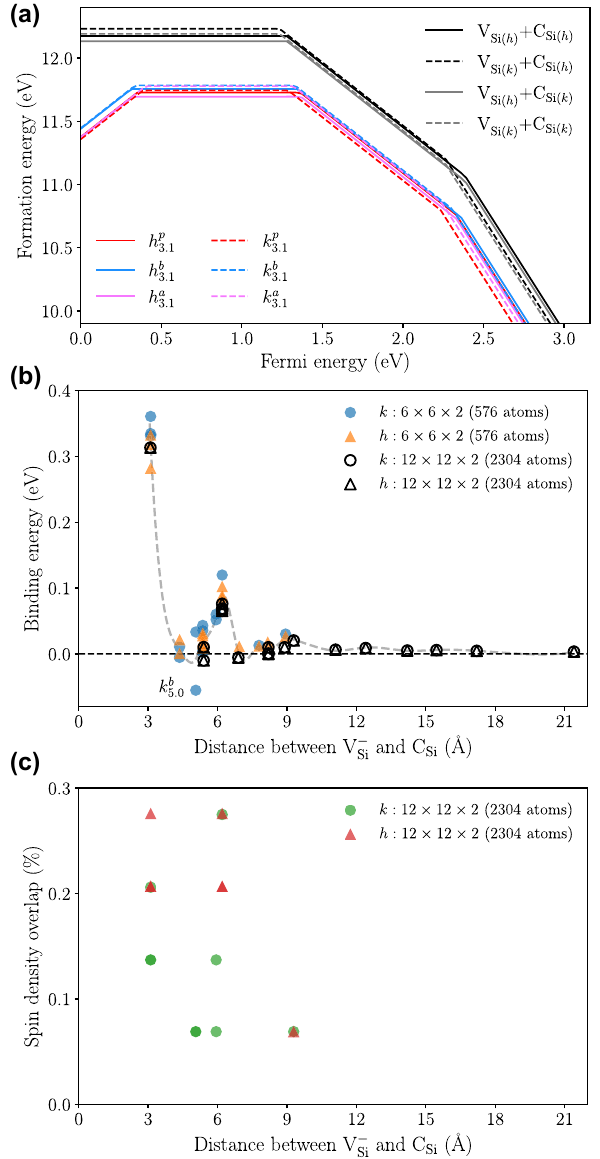
Figure 2: Energetics and the site dependent behavior of modified silicon vacancies. (a) The formation energy (HSE results) for the closest modified vacancy configurations (colored lines) compared to the isolated silicon vacancy and carbon antisite (black and grey Thus, the presence of electronically benign defects such as lines); (b) the binding energy as a function of distance between the antisites near spin defects should be studied with regards silicon vacancy and the carbon antisite. Notice the guideline to show the oscillating behavior of the binding energy. Here, the PBE results to the orientation of spin density. for the two different supercell sizes are shown. (c) The spin density Of the tested modified vacancy configurations, two overlap (PBE results) for the carbon antisite on the isolated silicon symmetry within 10 Å. The k a ′′ configuration has have C 3v 5 . 0 vacancy defect states. Sites with large spin density overlap in the smallest D value ( − 13.34, see Table 2 or Figure 5c) of all (c) correspond to the local maxima in binding energy in (b). the tested configurations and could be the defect respon- EPR signal [16]. The same configuration sible for the R 1 (namedV − -C (1)- k inRef.[30])alsohasthelowest D value. of this in Tables 1 and 2, the 3rd nearest neighbor site Si Si We draw the same conclusion as the authors in Ref. [30], has C symmetry but a low E value indicates that the k b 1h 4 . 4 configuration is responsible for R EPR signal. the k a ′′ electronic structure is close to C symmetry, see Figure 4. 1 3v 5 . 0